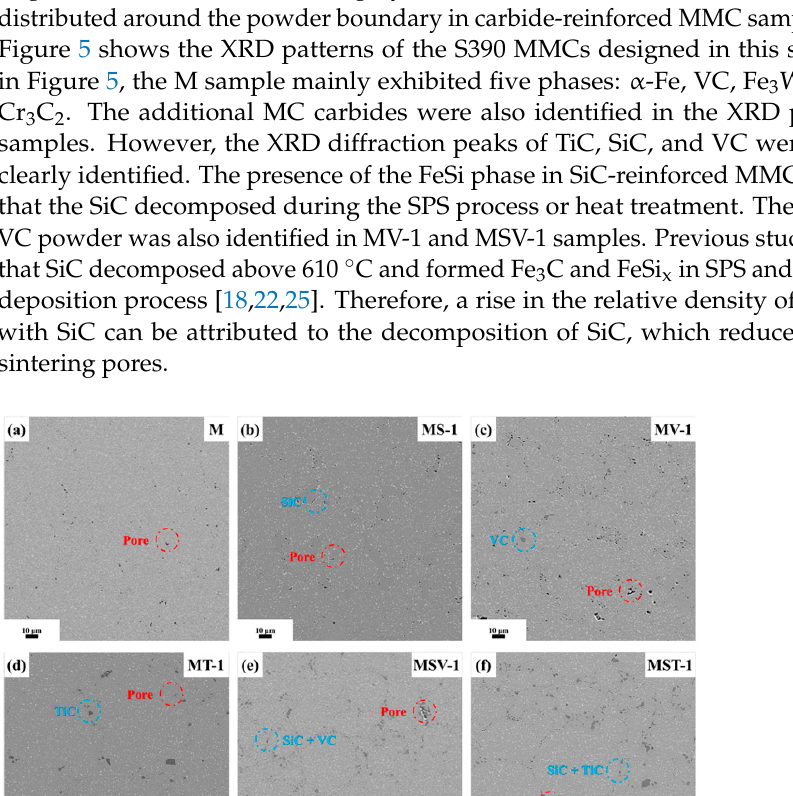
Figure 5. The XRD patterns of designed S390 MMCs designed in this study. The SEM micrographs of the M sample and EDS results of the S390 MMCs are pre- sented in Figure 6. As shown in Figure 6a, dark-gray and light-white particles were ob- served, which were V-rich MC carbides and W-rich M 6 C carbides, respectively. The ther- modynamic equilibrium of S390 HSSs was predicted using JMatPro. Additionally, the cal- culated equilibrium phase diagram is exhibited in Figure 6b. According to Figure 6b, the four major phases ( α -Fe, MC, M 6 C, and M 23 C 6 ) were identified at room temperature. The thermodynamic calculation results corresponded with the experimentally observed car- bide types shown in Figure 6a. The variations of elements were also investigated at vari- ous temperatures, and their results are shown in Figure 6c,d. As shown in Figure 6c, the MC carbide that existed at high temperatures had ~28 wt.% W elements, i.e., much higher than the ones that existed at room temperature. As a result, the MC carbide precipitated during the cooling process was mainly the V-rich MC carbide. The compositions of M 6 C carbides were also compared at different equilibrium temperatures. As shown in Figure 6d, the W content of M 6 C carbides at room temperature was approximately 17% higher than that at high temperatures. Therefore, the precipitation during cooling was mainly W- rich M 6 C.